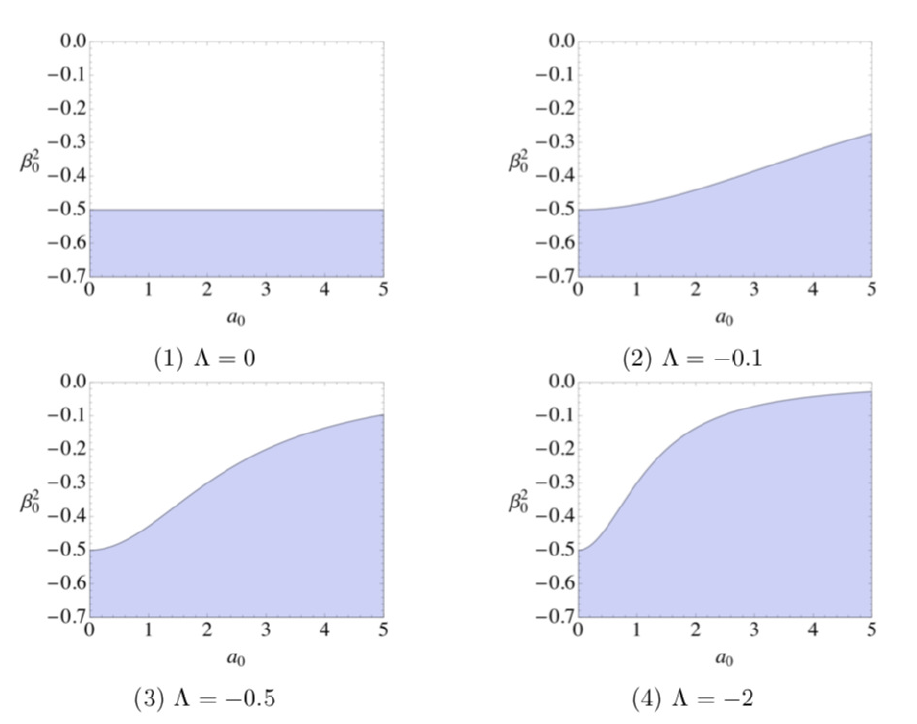
Figure 13. Anti de Sitter wormholes. Stable region is below the curve. Figure (1) describes a wormhole in the Minkowski